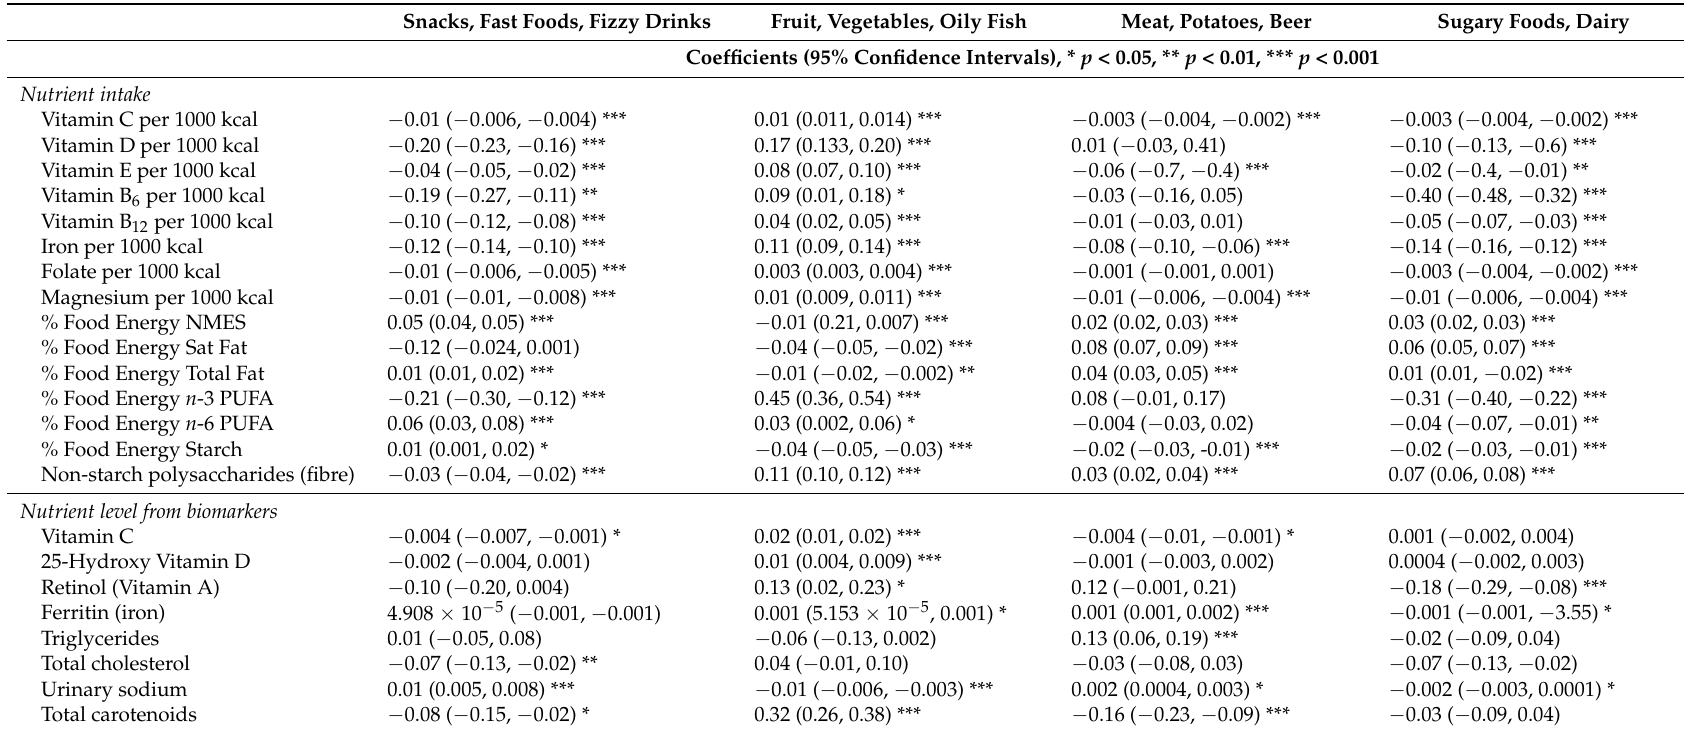
Table 6. Main effects (95% confidence intervals) of dietary patterns for self-reported nutrient intakes and biomarkers. Snacks, Fast Foods, Fizzy Drinks Fruit, Vegetables, Oily Fish Meat, Potatoes, Beer Sugary Foods,